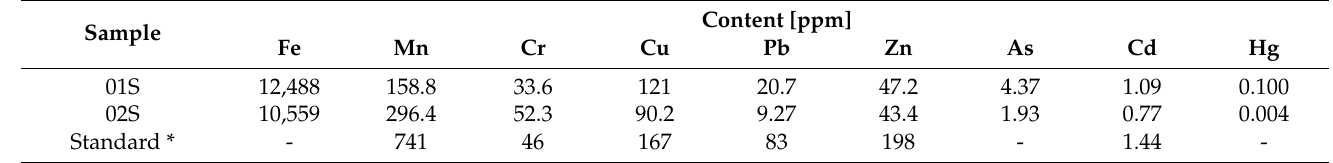
Table 2. Elemental composition of soil samples from Monchepluton.